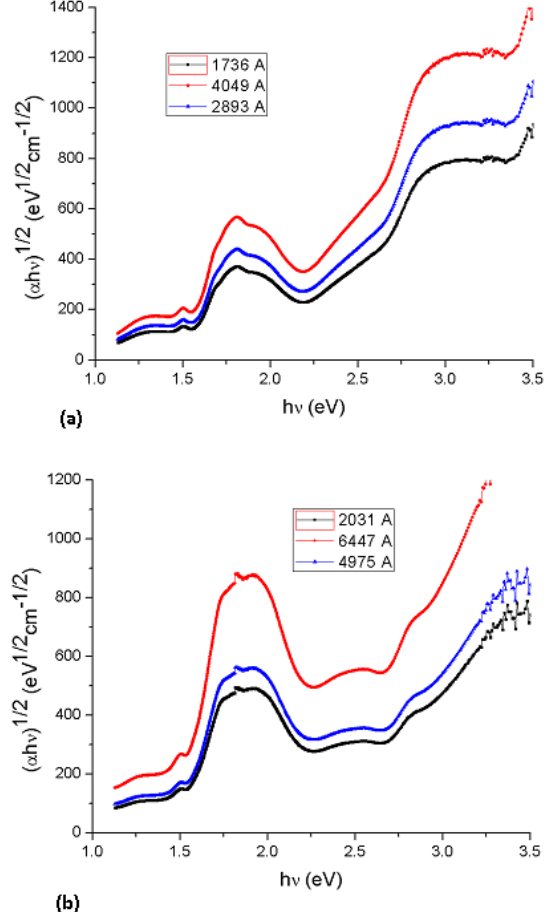
PcL1 and ( b ) Li PcL2 thin 2 2